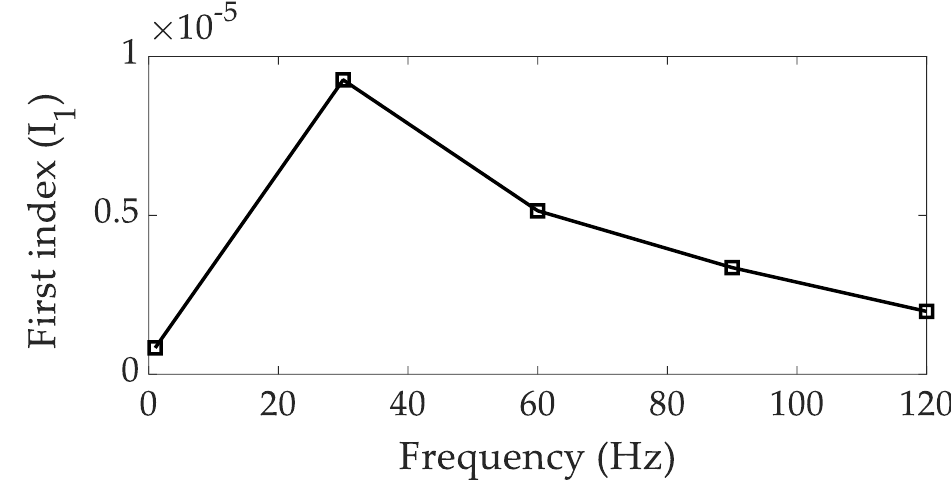
Figure 5. Variation in the first performance index as a function of frequency.